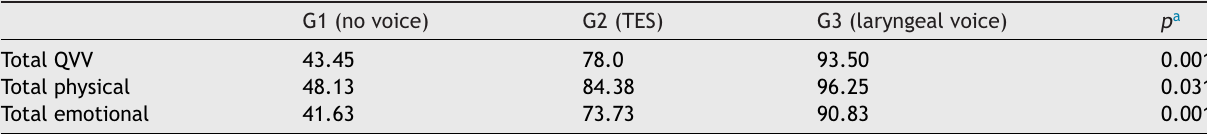
Comparative statistical analysis of the QVV questionnaire items according to the study group.